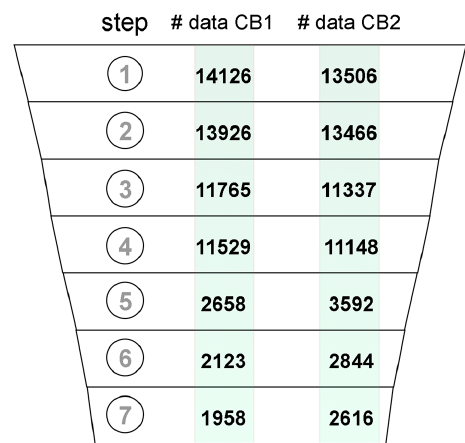
Figure 1. Data records that passed through the subsequent data curation steps: ( 1 ) data acquisition, ( 2 ) removing records with no SMILES included, ( 3 ) removing records with Confidence Score < 8, ( 4 ) keeping only records from large assays, ( 5 ) keeping only records with included Ki values, ( 6 ) duplicate merging, ( 7 ) removing molecules with the same feature vector.